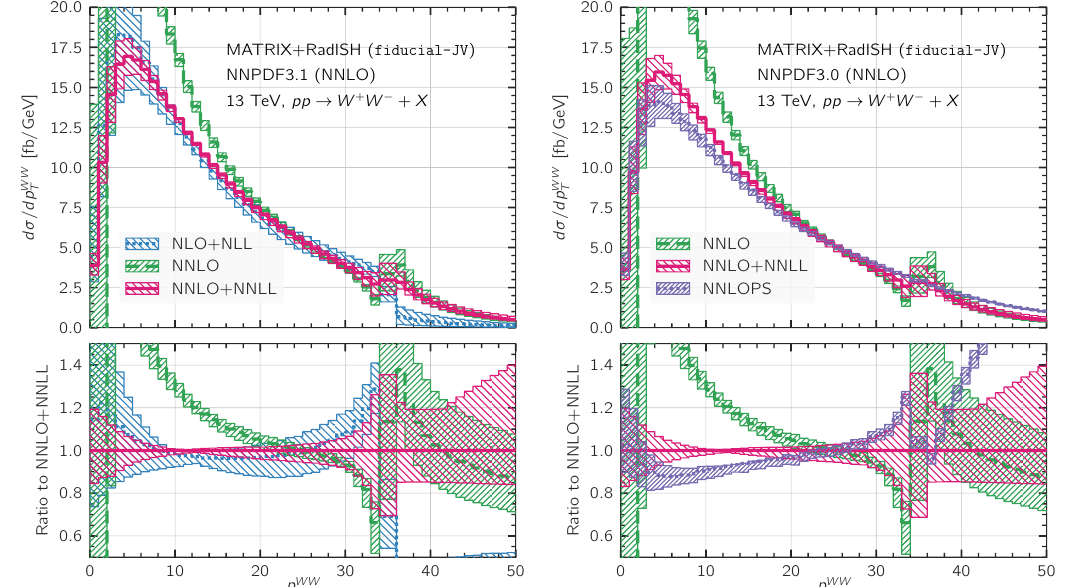
Figure 8 . Left plot: transverse-momentum spectrum of the W + W − pair with a jet-veto re- quirement in the fiducial-JV phase space at NLO+NLL (blue, dotted), NNLO (green, dashed), and NNLO+NNLL (red, solid) accuracy. Right plot: same distribution comparing NNLO (green, dashed) and NNLO+NNLL (red, solid) predictions to the NNLOPS result (blue, dotted) of ref. [83]. To facilitate the comparison, we reanalysed the NNLOPS events and we recalculated our predictions with the NNPDF3.0 NNLO PDF set [161]. The lower frame shows the ratios of the predictions to the central value of the NNLO+N 3 LL